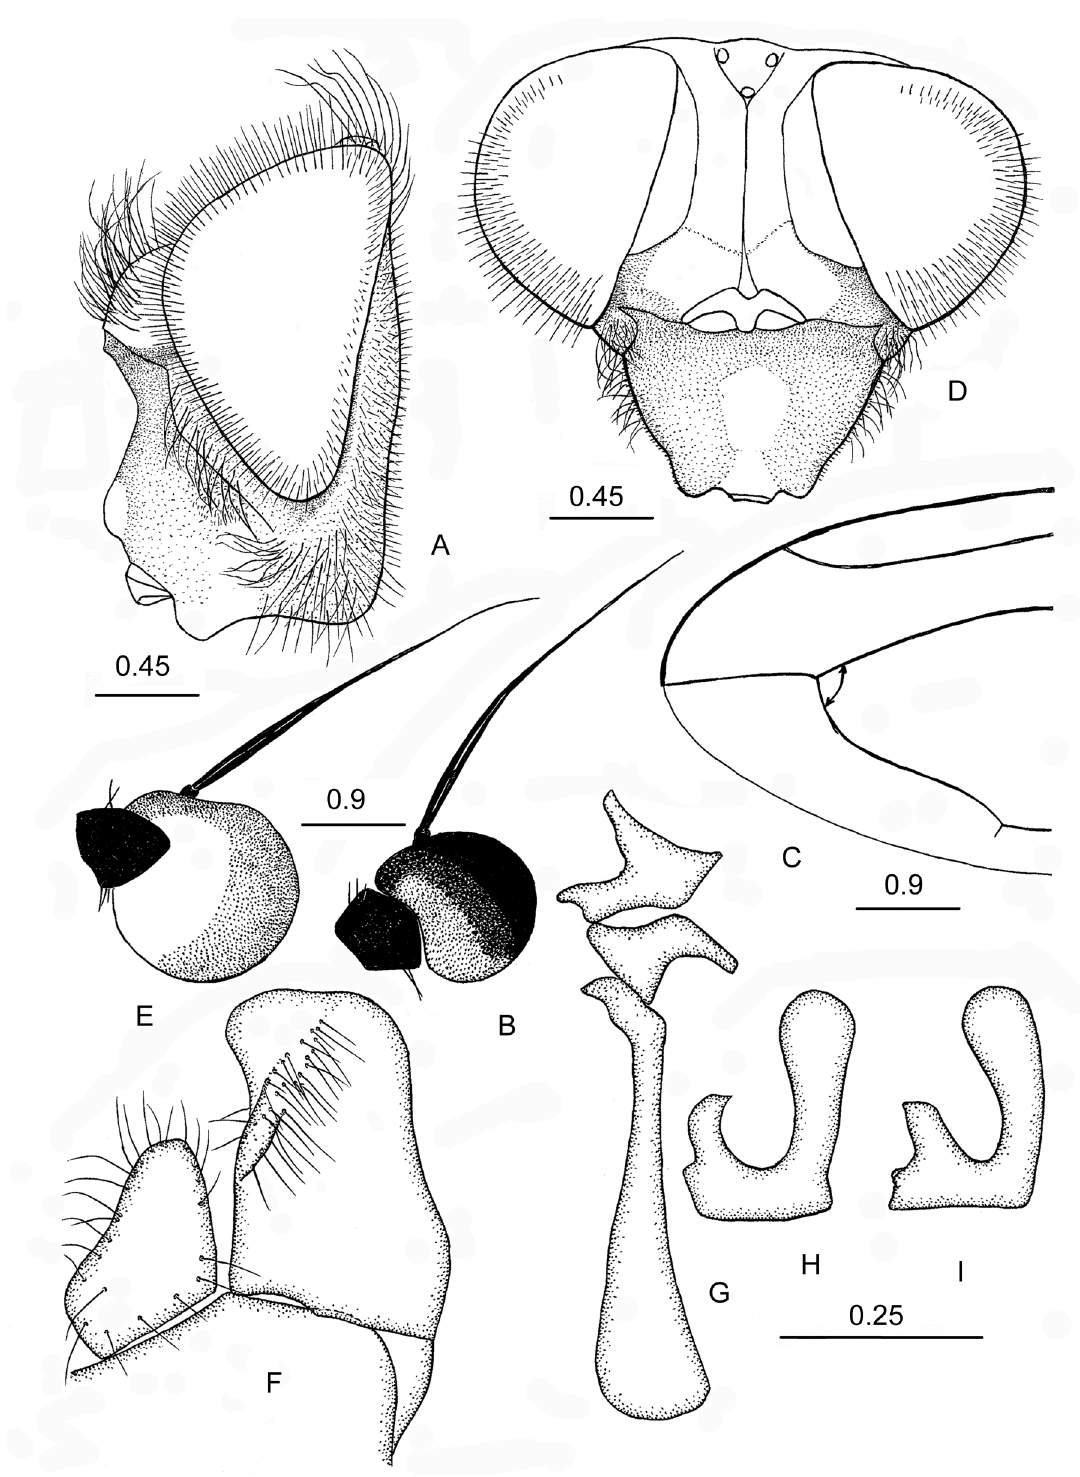
Fig. 5. Cheilosia ( Montanocheila ) alpha sp. nov.; A–C, F–I = paratype, ♂ (CNC), D–E = paratype, ♀ (CNC). A . Head, lateral view. B . Antenna, lateral view of pedicel and basoflagellomere. C . Tip of wing. D . Head, dorsal view. E . Antenna, lateral view of pedicel and basoflagellomere. F . Surstylus and gonocercus, lateral view. G . Aedeagus and aedeagal apodeme, lateral view. H–I . Superior lobes of hypandrium, lateral view. Scale bars indicated in